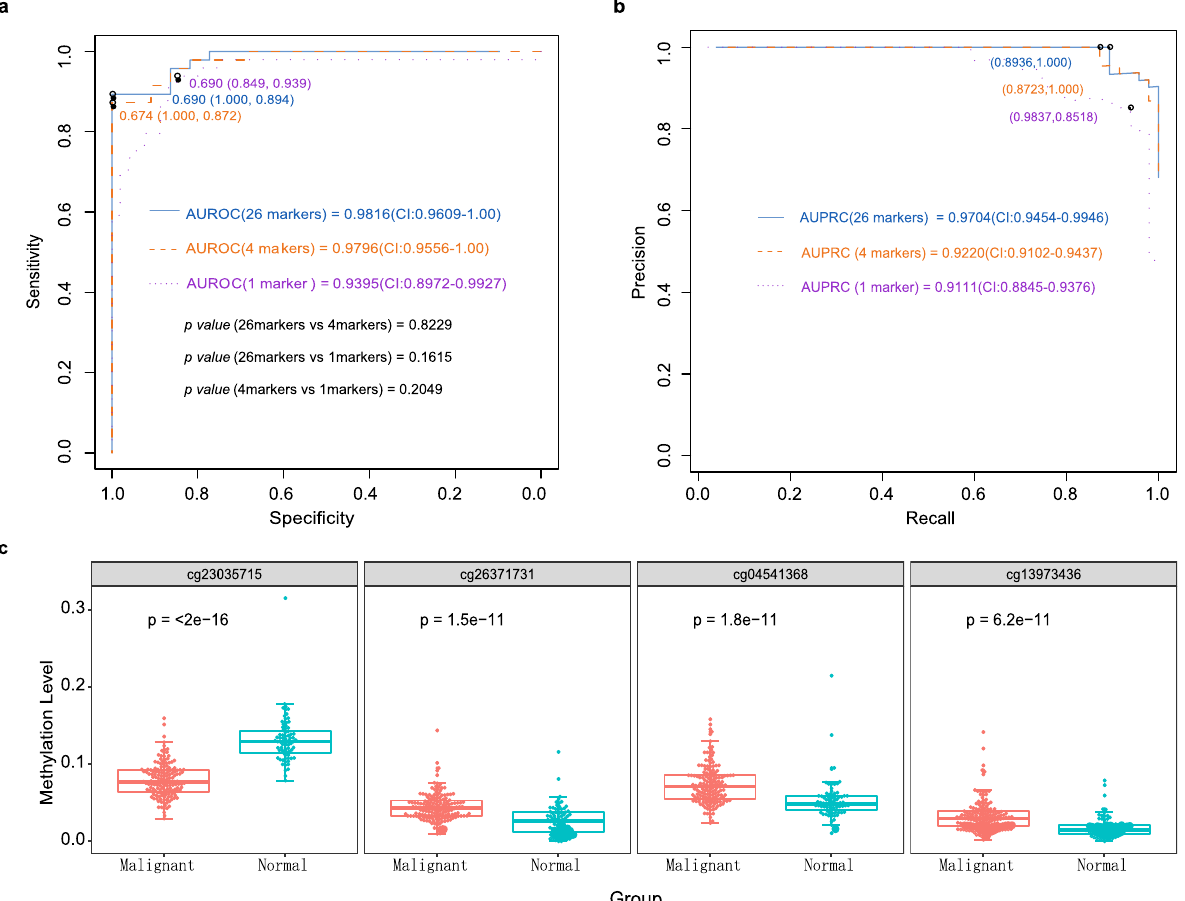
Fig. 3 ROC and PRC curves using different models and methylation levels of four markers between malignant and normal plasma samples. a , b In the validation group, three different models were used for cancer detection. The fi rst model included 26 markers (Supplementary Table 1) and achieved the best diagnostic power, with AUROC of 0.9816 (95% CI: 96.09 – 100%), and AUPRC of 0.9704 (95% CI: 94.54 – 99.46%). The second model included 4 markers (Supplementary Table 1) and achieved similar diagnostic power, with AUROC of 0.9796 (95% CI: 95.56 – 100%), and AUPRC of 0.9220 (95% CI: 91.02 – 94.37%). This model is suitable for PCR-based methods in future cancer screens. The last model included 1 marker, cg23035715 , which achieved the best diagnostic power based on a single marker, with AUROC of 0.9395 (95% CI: 89.72 – 99.27%), and AUPRC of 0.9111 (95% CI: 88.45 – 93.76%). c Box plot showing the top four markers of increased and decreased methylation levels in malignant ( n = 155) vs. normal ( n = 74) plasma samples. The methylation level of cg23035715 in normal plasma is higher than that in breast cancer plasma. It is different from other markers. P values were calculated using analysis of variance. For each box plot, the centre line, the boundaries of the box, the ends of the whiskers and points beyond the whiskers represent the median value, the interquartile range, the minimum and maximum values, and the outliers,